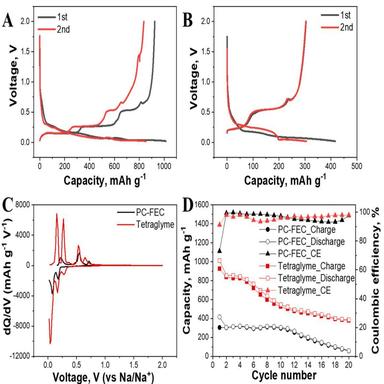
Charge/discharge curves of microsized Sn electrode during cycling in (A) ether-based and (B) carbonate-based electrolytes at 90 mA g− 1 . (C) The corresponding initial dQ/dV curve and (D) cycling performance of microsized Sn electrode in two electrolytes.